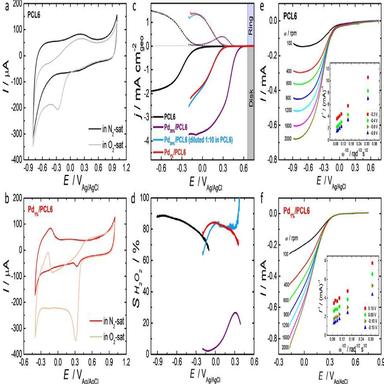
(a, b) Cyclic voltammograms obtained in N2 and O2-sat 0.1 mol L1 K2SO4 at pH 2.5 for GC electrodes modified with PCL6 and Pd1%/PCL6 (scan rate: 50 mV s1 ; scans started at 1.0 VAg/AgCl). (c) Linear sweep voltammetry in an RRDE configuration scanning the potential at 5 mV s1 and 900 rpm in O2-sat 0.1 mol L1 K2SO4 at pH 2.5 (scans started at 0.9 or 0.2 VAg/AgCl). (d) SH2O2 during the ORR at varying potentials (obtained from the corresponding RRDE data). (e, f) Linear sweep RDE results scanning the potential a